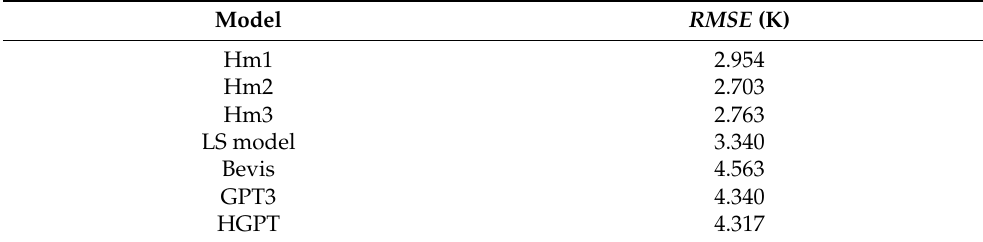
Table 3. The overall accuracy of different models.